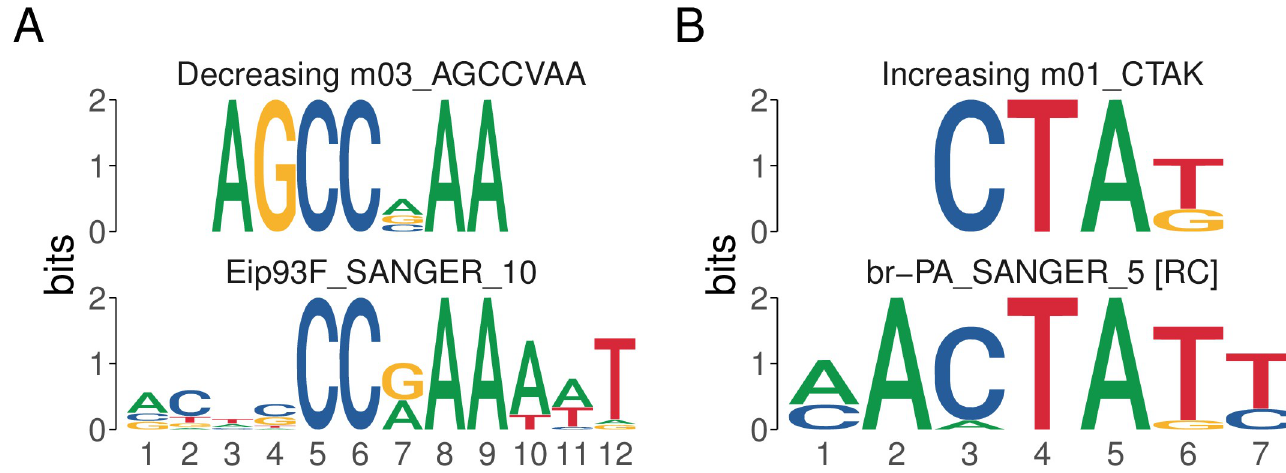
Fig 2. Representative plots generated by view_tomtom_hits showing the top hit for motifs discovered in decreasing (A) and increasing (B) peaks.